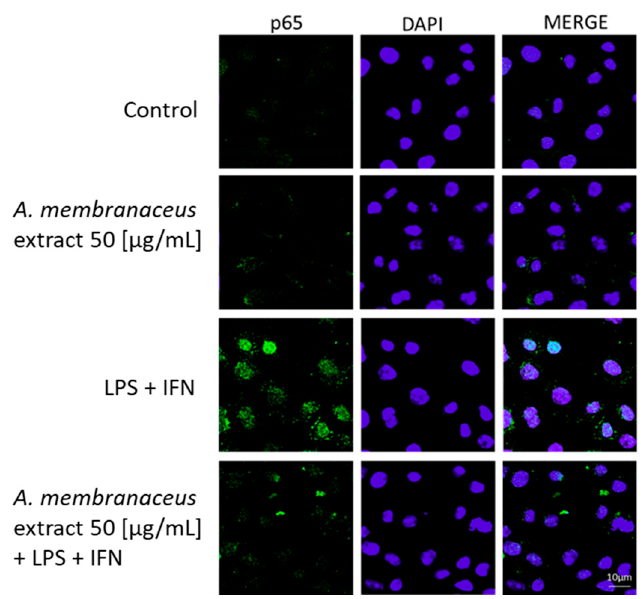
Figure 2. Effects of Astragalus membranaceus extract (50 µg/mL) alone and with LPS + IFN on nuclear factor- κ B (NF- κ B) p65 nuclear translocation, evaluated by immunofluorescence analysis. The blue fluorescence identified the nuclei, while the green fluorescence indicated the p65 NF- κ B subunit.